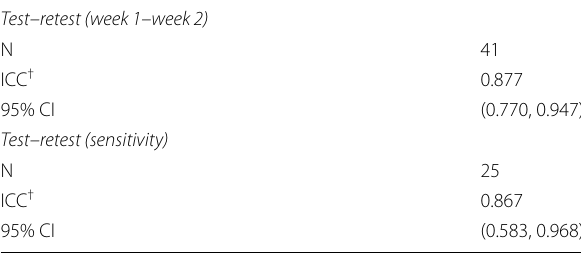
CI confidence interval, ICC intraclass correlation coefficient, N total sample size, NRS numeric rating scale *ICC and 95% CI were estimated through bootstrap (n †